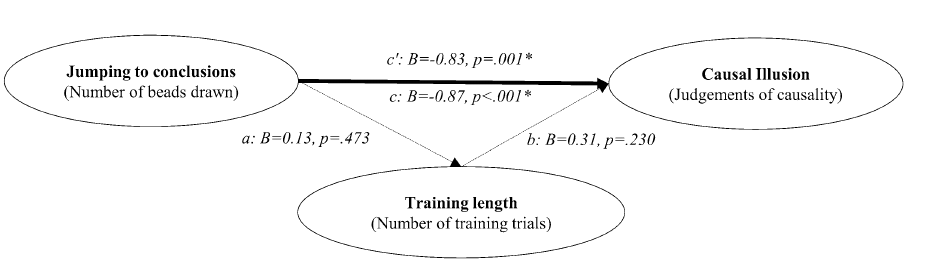
Figure 10. Path model in Study 2. The letters a, b, c, and c’ depict the paths between the three variables, which are weighted by the regression coefficients. Significant coefficients ( p < .05) are denoted with an asterisk. The total effect (path c) can be decomposed into two components, the direct effect and the indirect effect. Paths a and b represent the indirect effect that operates via the mediator, the number of training blocks required in